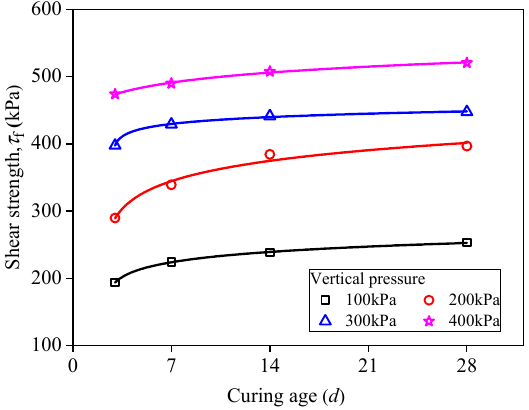
Figure 12. Relationship between shear stress and curing age ( D R = 30%).